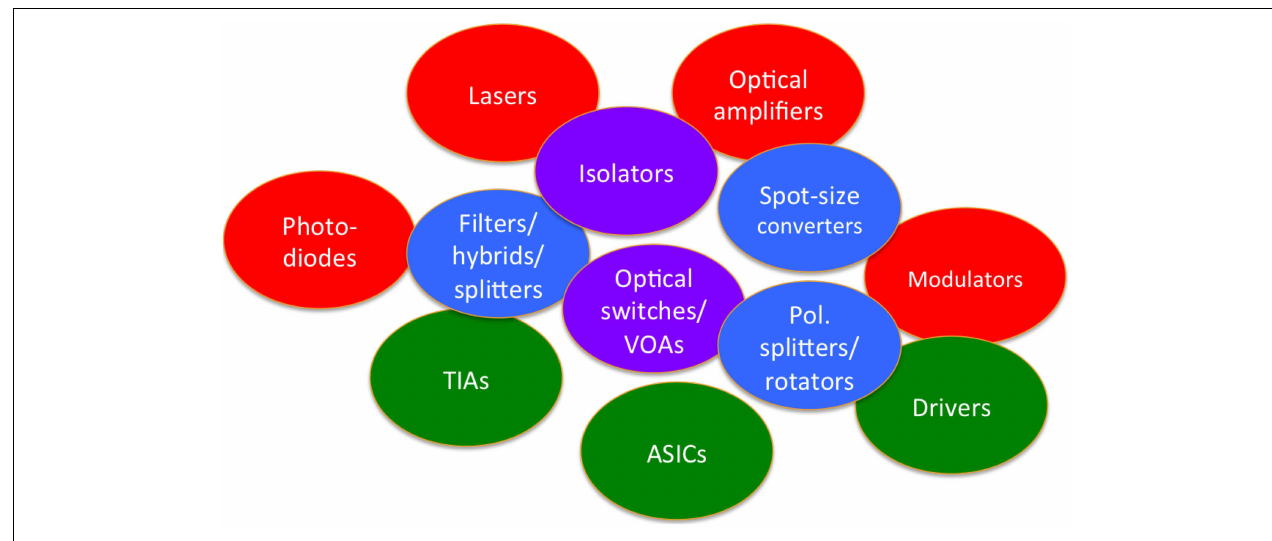
FIGURE 3 | Some of the possible PIC integration elements.